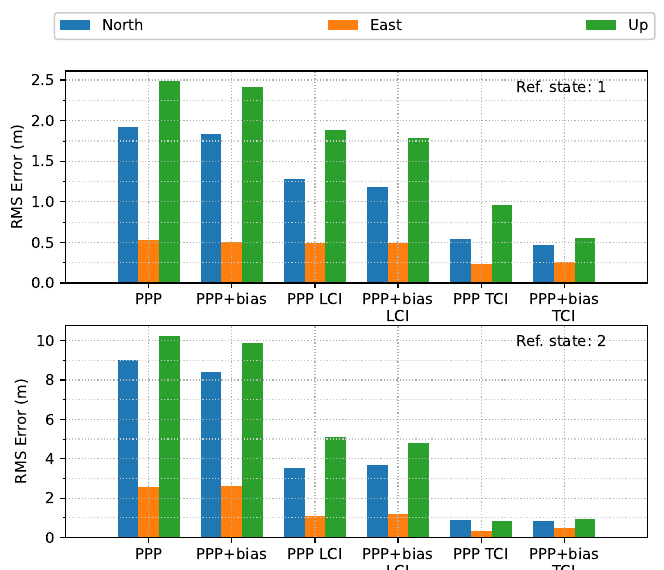
Figure 30. Error RMS of real-time GPS/Galileo PPP/INS results of city center test on 27 January 2022 with respect to IE RTK/INS TCI solutions.